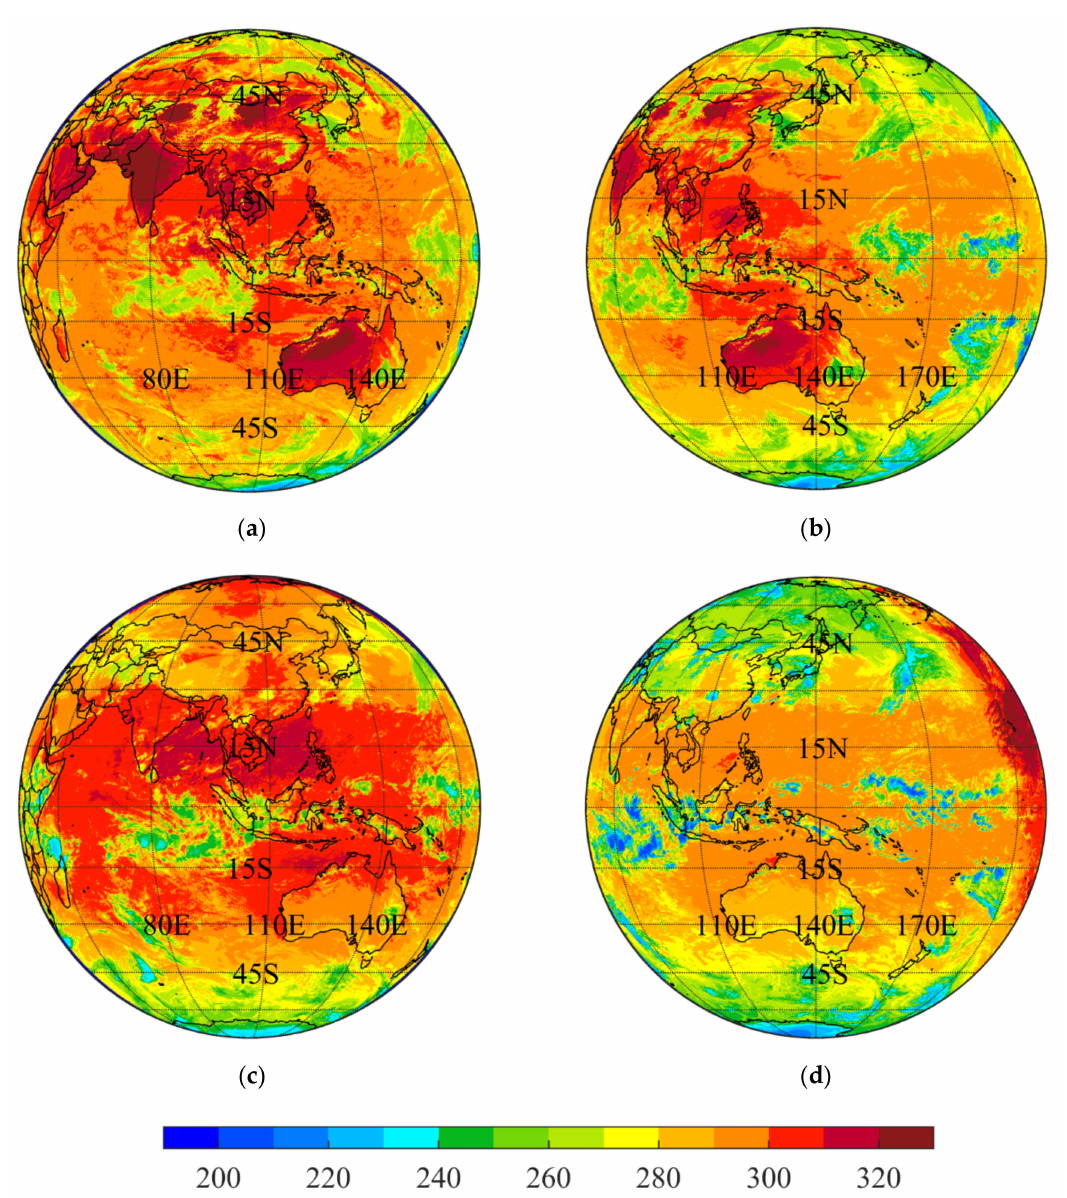
Figure 2. Observed brightness temperature distributions at ~3.75– µ m for ( a , c ) FY–4A/AGRI band 8 and ( b , d ) Himawari– 8/AHI band 7 ( a , b ) at 0600 UTC and ( c , d ) at 1700 UTC on 23 April 2019. (Unit: